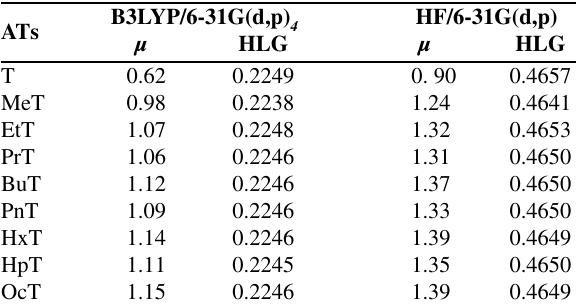
Table 2. Calculated HOMO-LUMO gaps (eV) and electrical dipo- le moments (Debye) for studied species. B3LYP/6-31G(d,p) HF/6-31G(d,p) 4 ATs